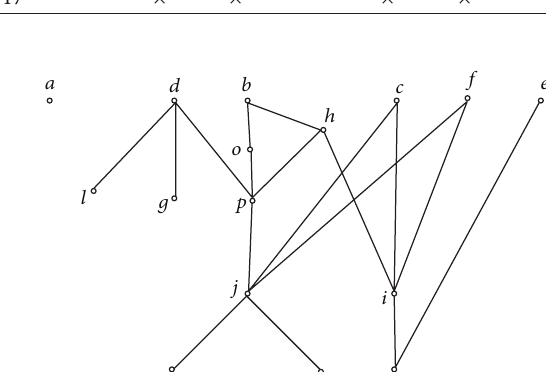
Figure 7: (𝐻 𝑚 ,≤) of (𝐺, 𝑀, 𝐼) in Table